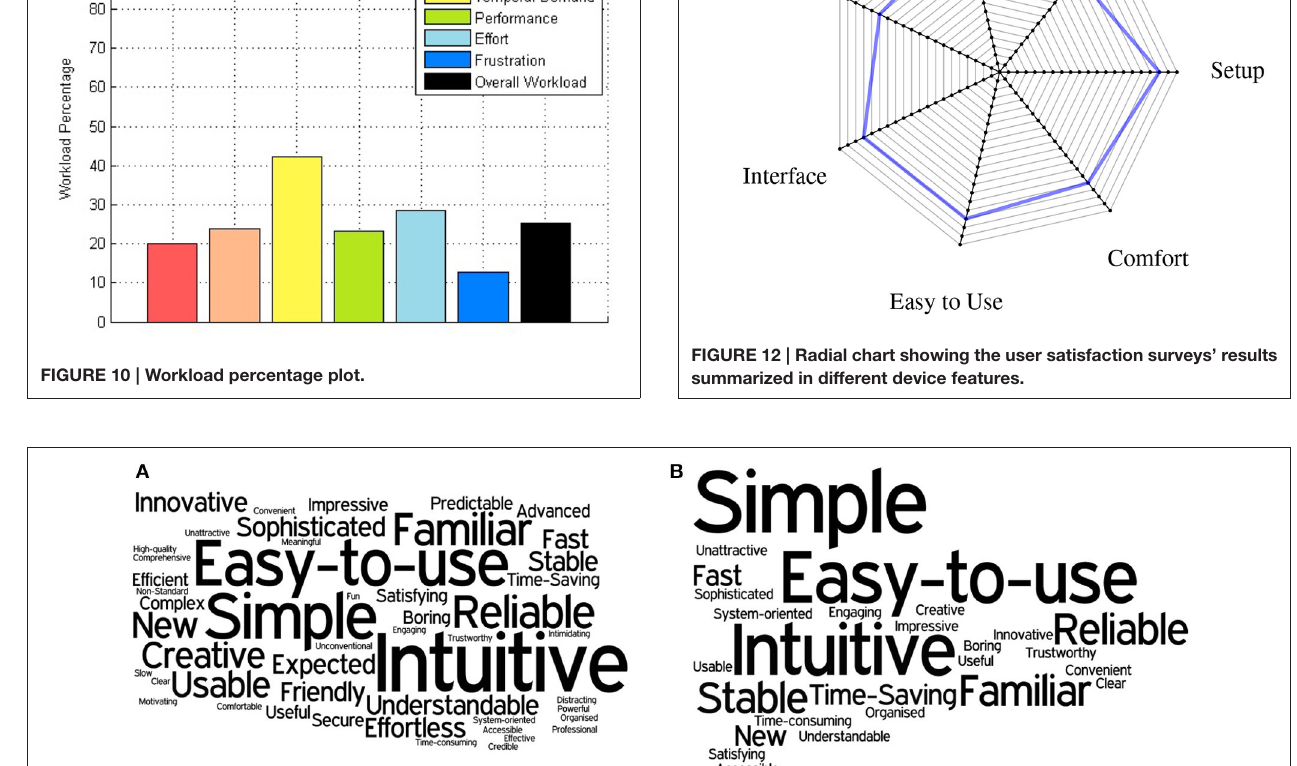
Frontiers in Neurorobotics |